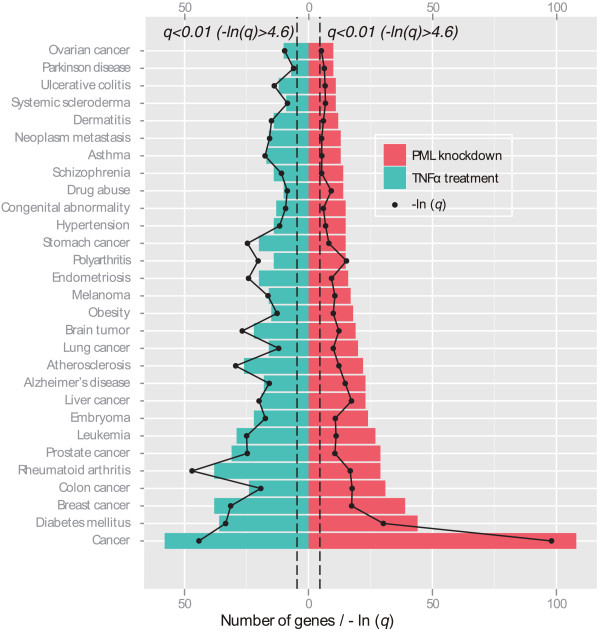
PML function and TNFα signaling are linked to multiple human diseases. The significantly affected genes by PML knockdown and TNFα signaling are significantly associated (q < 0.01) with multiple human diseases analyzed as described in Methods using a Disease Ontology database. The diseases are sorted vertically according to the number of associated significantly altered genes following PML knockdown. The transformed values (−ln(qvalue)) of FDR adjusted p value for each category of diseases are shown in the same graph. The dashed lines indicate −ln(q = 0.01) ≈ 4.6.